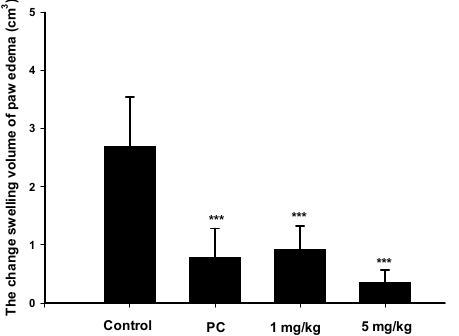
Figure 4. Change in the swelling volume due to paw edema after a mono-iodoacetate (MIA) injection in the ankle of a rat on days 1 to 4. The positive control (PC) was indomethacin (10 mg/kg). *** p < 0.0005 compared to the control.